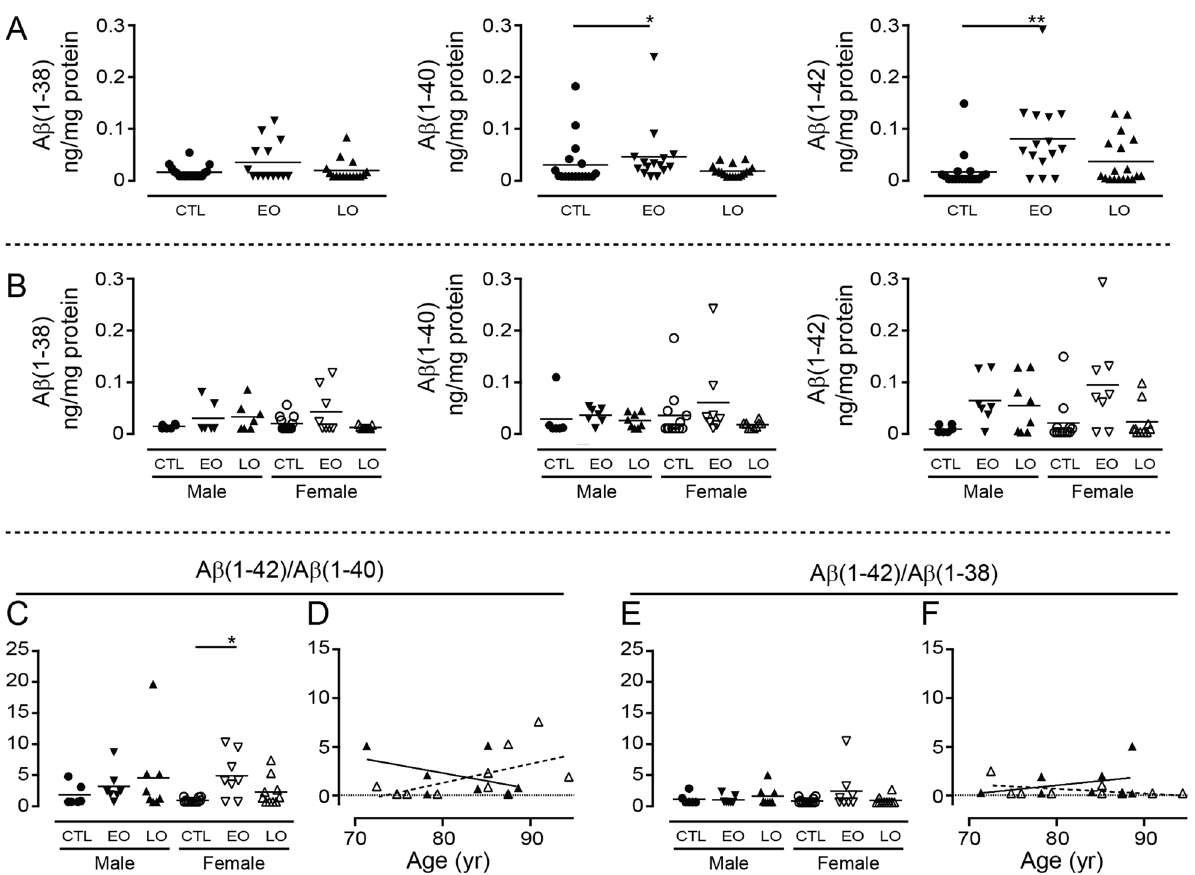
Figure 8. Levels of Aβ peptides isolated from RIPA-soluble human hippocampal extracts. Densitometric analyses were performed on the hippocampal samples from the same donors as described in Fig. 7. Levels of peptides were analyzed by ( A ) diagnosis or ( B ) stratified by sex and diagnosis. The data were expressed as ( C ) Aβ(1–42)/Aβ(1–40) or ( E ) Aβ(1–42)/Aβ(1–38) ratios and ( D , F ) the relations between these ratios and age of the donor at autopsy were examined by regression analysis. *: P < 0.05; **: P < 0.01 vs. corresponding controls (CTL). EO: Early-Onset AD; LO: Late-Onset